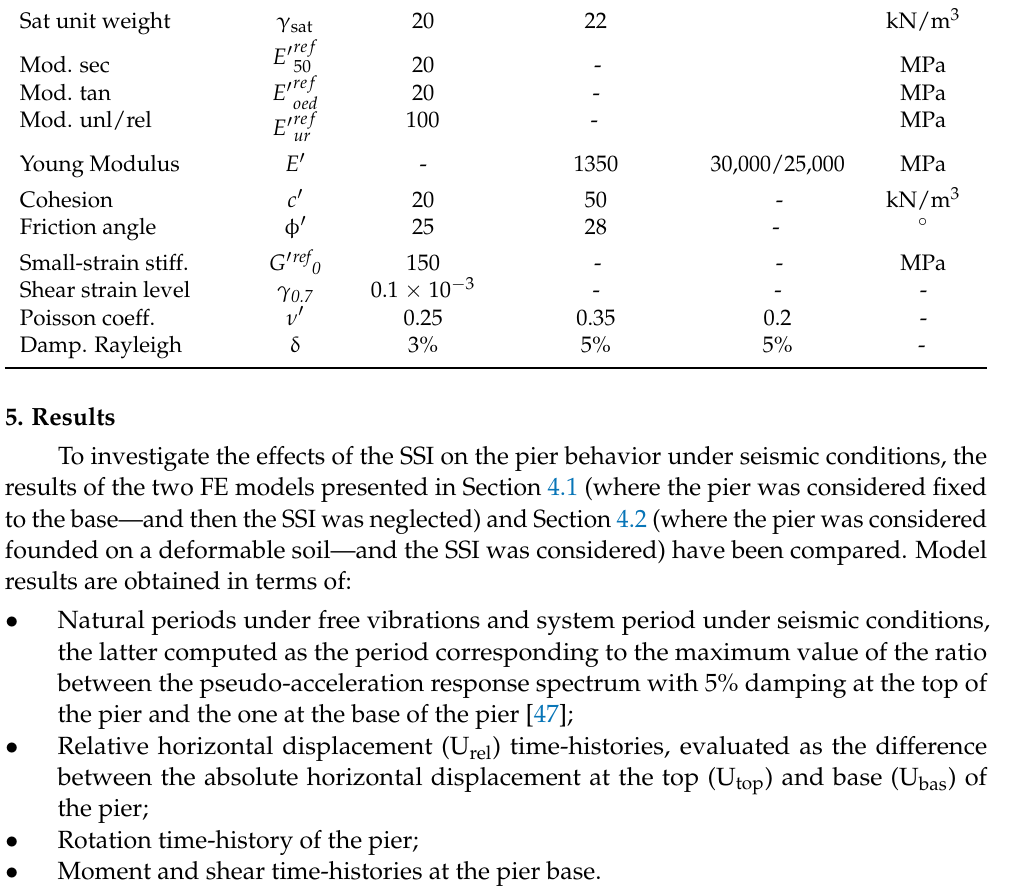
Table 2. Summary of the adopted soil properties. Parameter Symbol Clayey F. Marly F. r.c. Constit. model - HS-small Mohr-Coulomb Linear Elastic - Dry unit weight γ s Sat unit